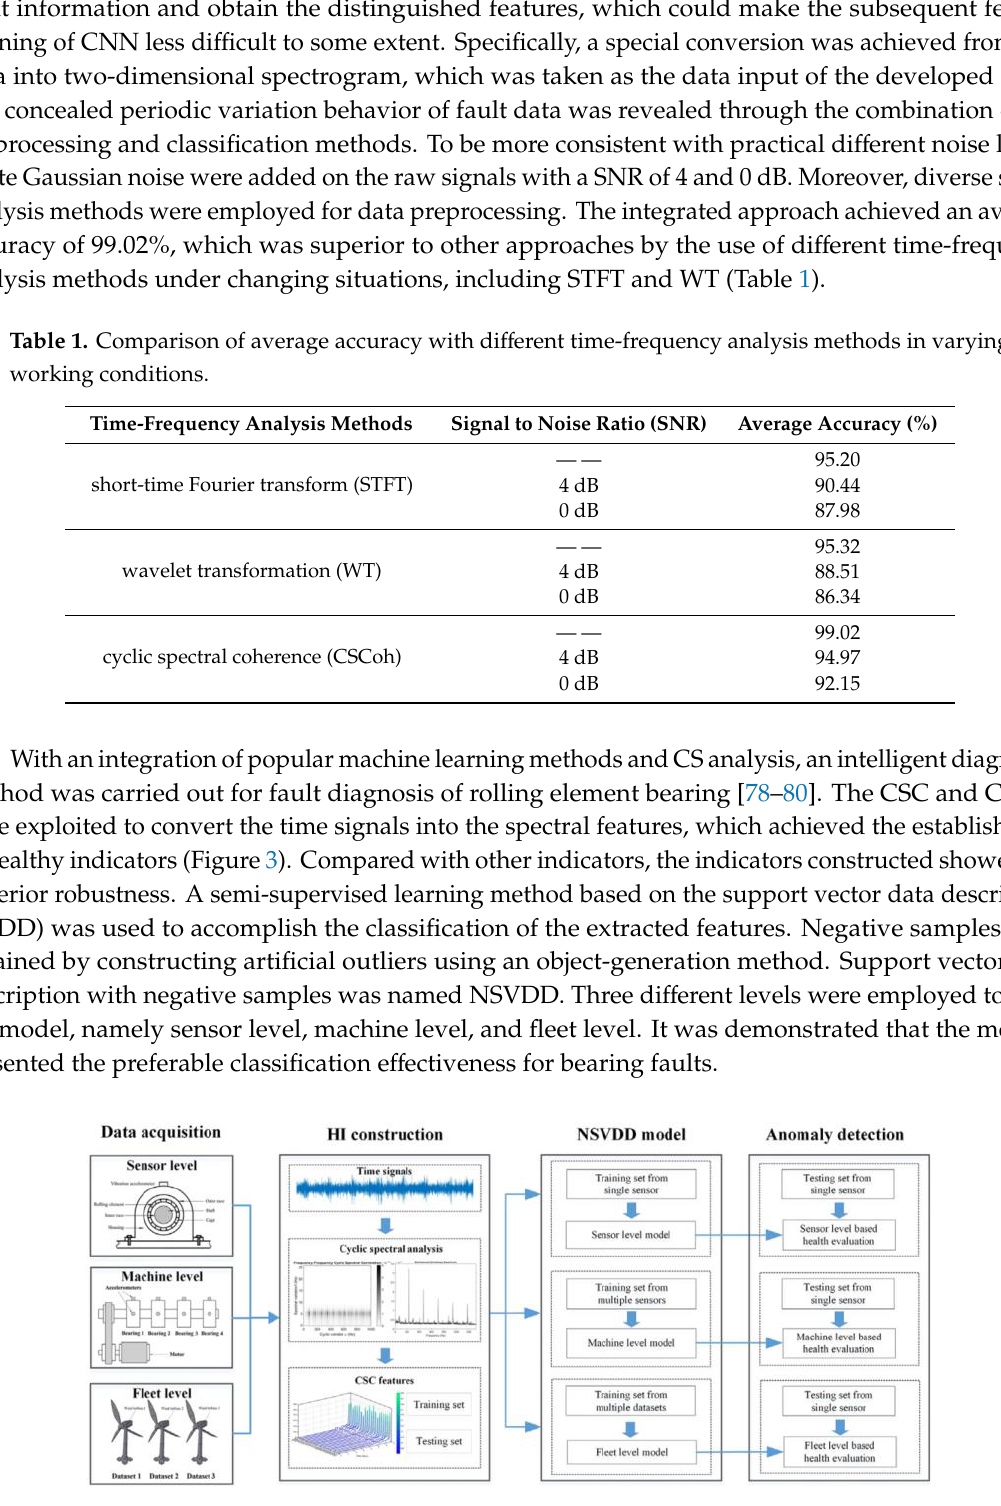
Figure 3. The anomaly detection framework with NSVDD model, evaluated on three levels: (i) Sensor level, (ii) machine level, and (iii) fleet level. NSVDD denotes support vector data description with negative samples.